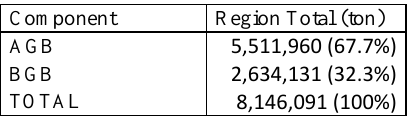
Table 2.AGB and BGB estimation for Tarapacá Region.